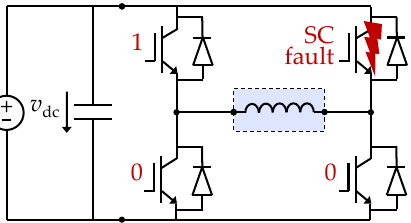
Figure 16. Tolerance to a switch SC by clamping both terminals of a stator phase through an FB VSC (causing phase SC), as in